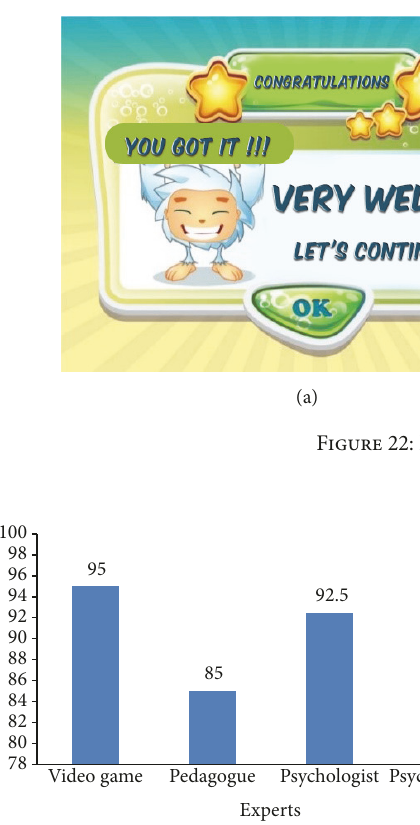
Figure 23: Result of the ALTRIRAS usability test performed by the